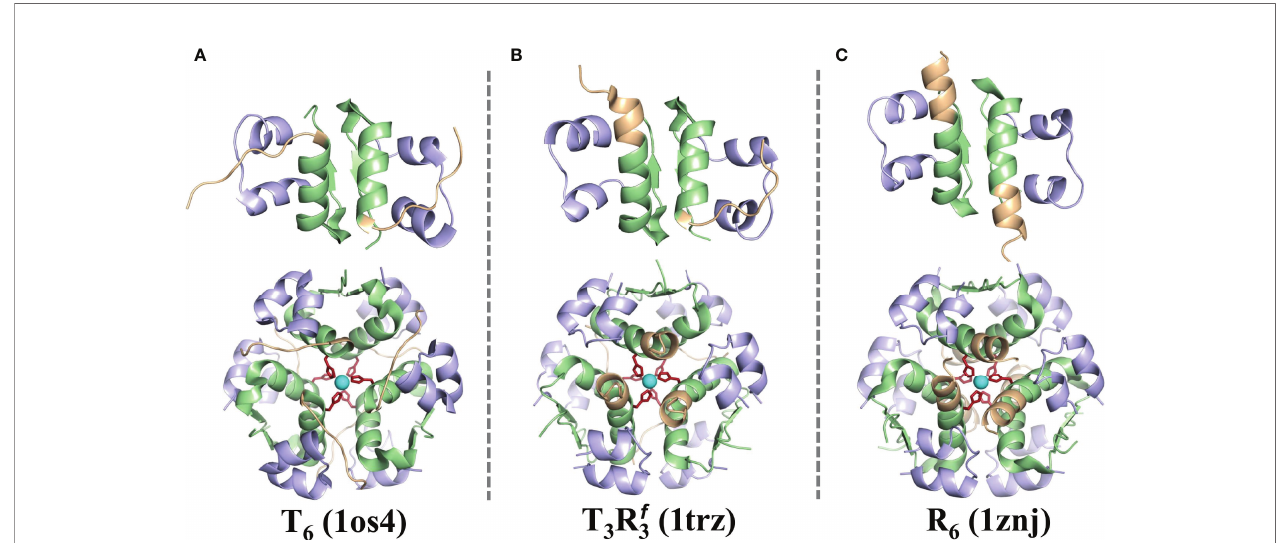
FIGURE 2 | The T 6 , T 3 R f 3 , and R 6 forms of insulin. The cartoon representations of the structures of dimeric and hexameric forms of insulin are shown in the T 6 (A) , T 3 R f 3 (B) , and the R 6 (C) states. The key residues of the B-chain (B1-B8) that exhibit a distinct structural transition from an extended to a helical conformer are depicted in light brown. cf. Figure 1 for color scheme and other details.